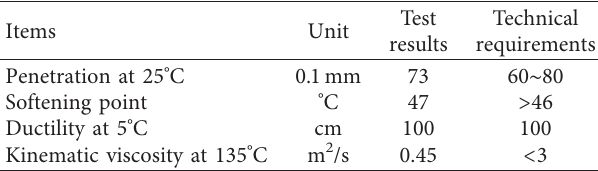
Table 2: Technical index of #70 road petroleum